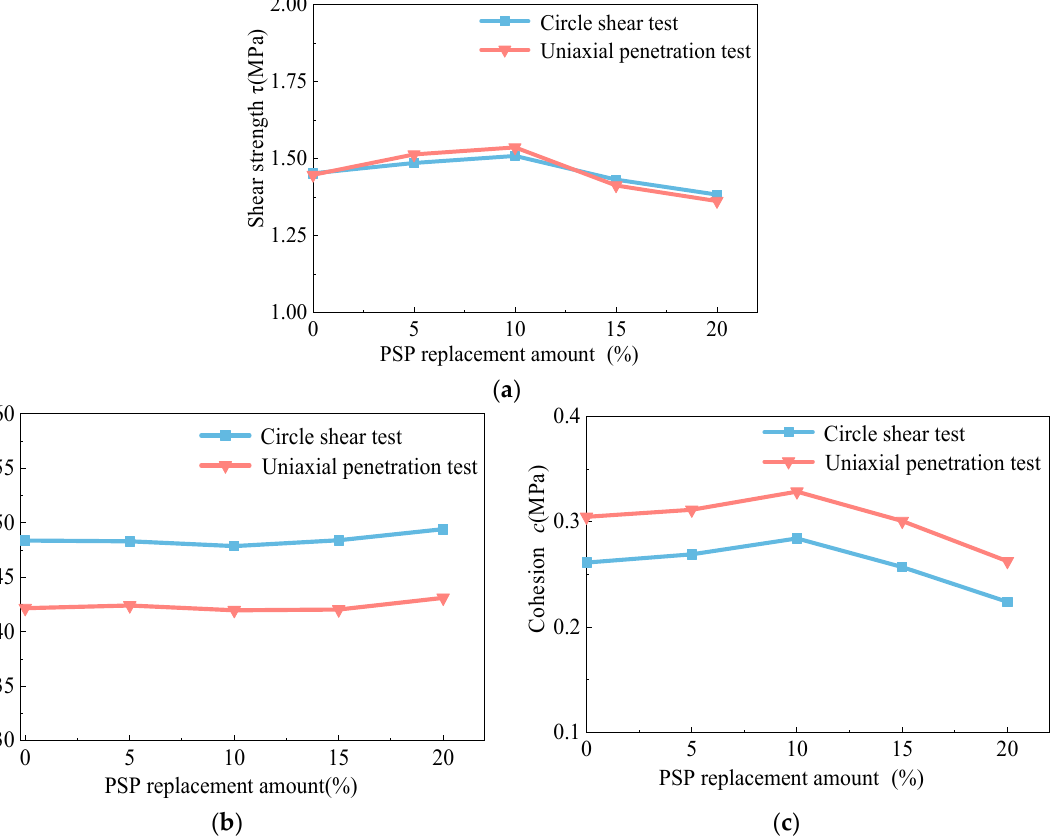
Figure 13. Effects of PSP replacement amount on Shear strength, internal friction angle, and cohesion. ( a ) Shear strength; ( b ) Internal friction angle; ( c ) Cohesion.